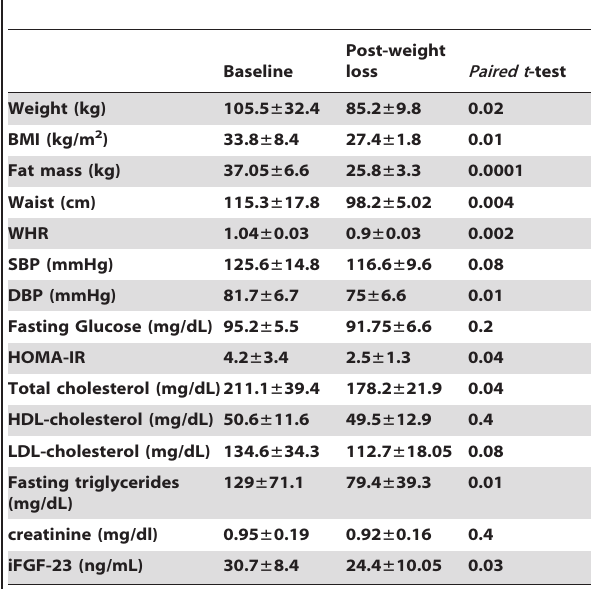
Table 5. Subjects’ characteristics in the diet-induced weight loss study (10 men, aged 43 6 15 years).